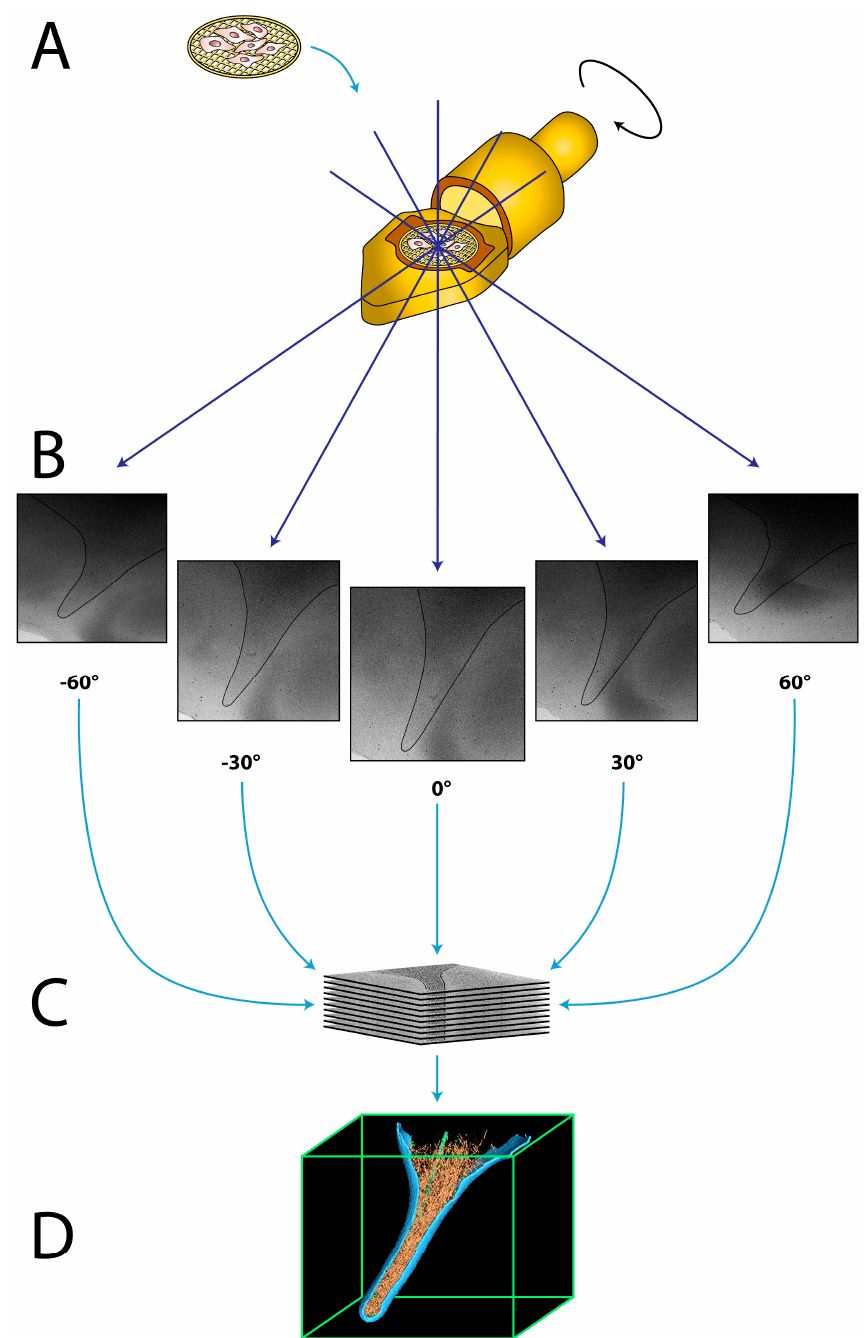
Figure 1. The principle of cryo-electron tomography (cryo-ET). ( A ) The grid containing the vitrified sample is inserted into the cryo-specimen holder of the electron microscope. ( B ) The specimen holder is tilted incrementally around an axis perpendicular to the electron beam, typically from − 60 to +60°, while acquiring multiple micrographs. Black line illustrates the plasma membrane of the acquired cell. ( C ) The tilt series is computationally aligned and reconstructed into a 3D density map, a tomogram. ( D ) The 3D tomogram can be inspected and individual components are visualized by surface rendering.